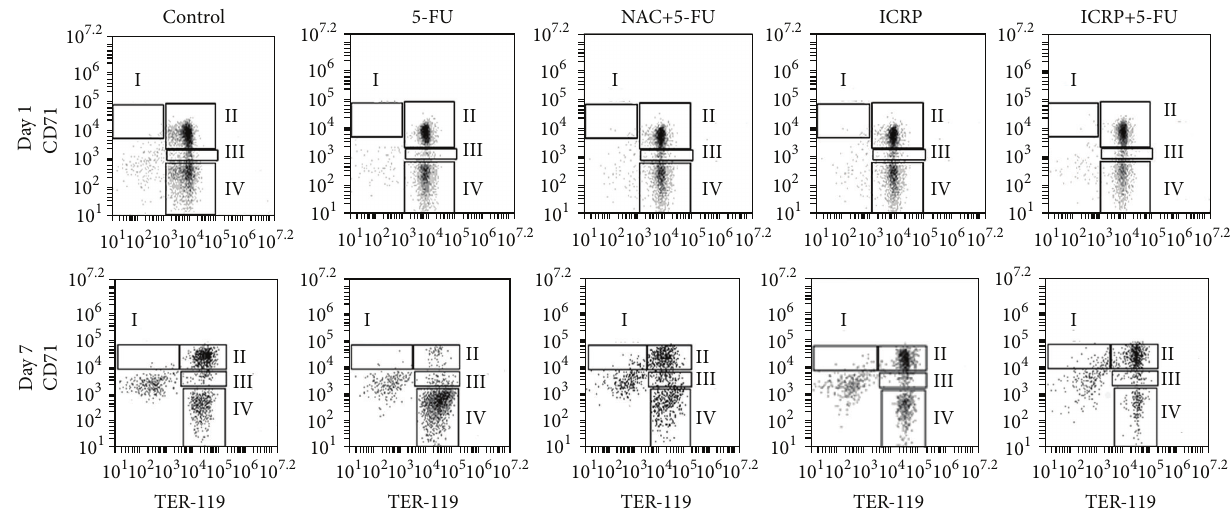
Figure 4: Flow cytometry analysis: representative result of flow cytometry analysis. BM cells from both femurs and tibias were obtained on day 7 from treated mice. Subsequently, BM cells were analyzed for expression of the cell surface markers CD71 and Ter119 by flow cytometry. Populations I to IV represent progressive maturation of erythroid cells. Populations are characterized by I, proerythroblasts; II, basophilic erythroblasts; III, orthochromatic erythroblast; and IV, enucleated red blood